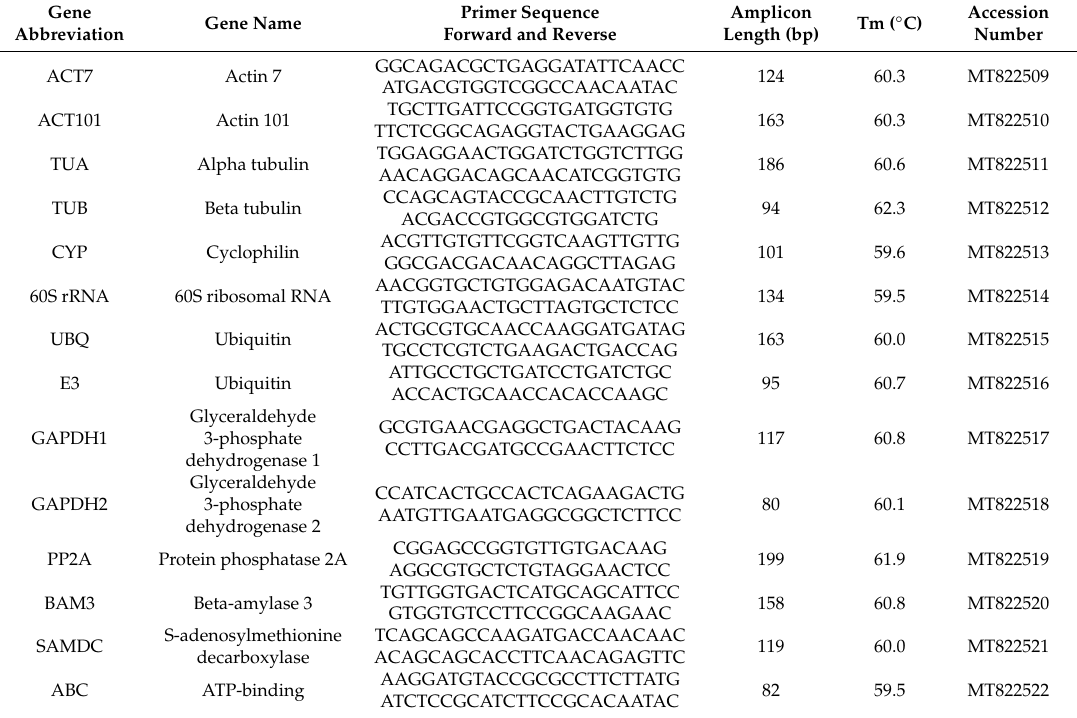
Table 1. Primer sequences for 14 reference genes used in the real-time qRT-PCR